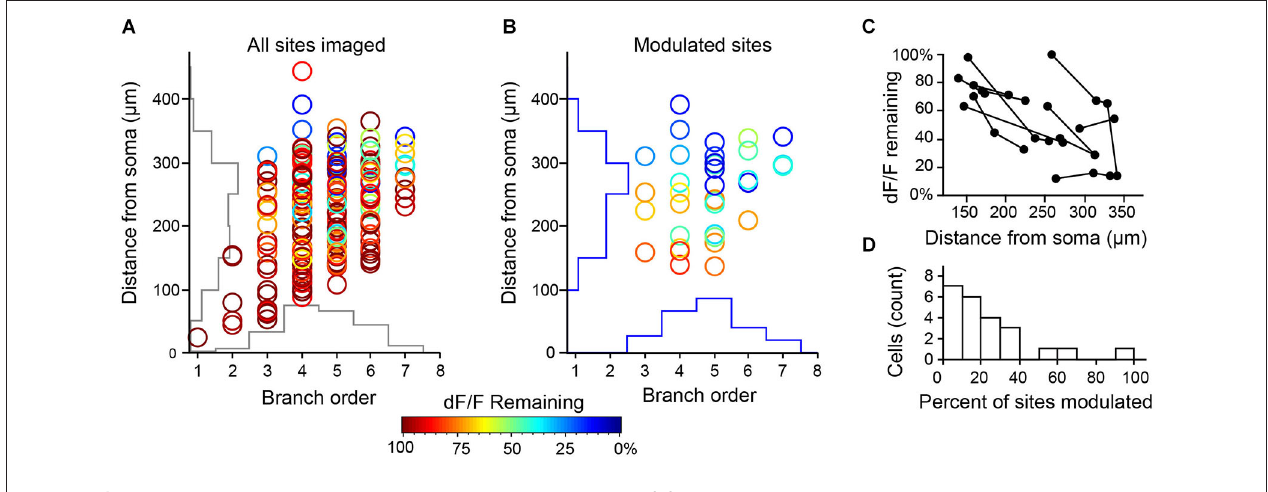
FIGURE 7 | Summary of modulation at all imaging sites for L1 interneuron-PC pairs. (A) ( N = 201 sites, 23 cell pairs from 23 slices and 22 mice). Axes show corresponding histograms of imaging locations. (B) Distribution of sites with significant modulation (36 sites in 17 cell pairs, p < 0.05, 3–5 trials/condition) show strongest effect on most distal dendrites.